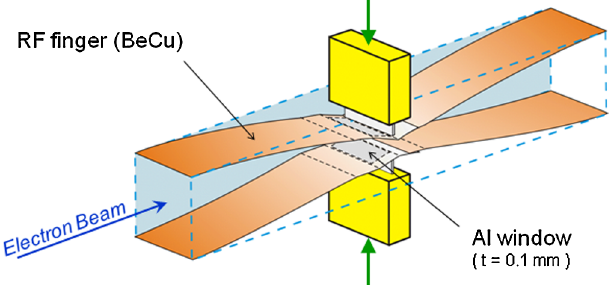
FIG. 8. Schematic view of the rf fingers with aluminum windows.